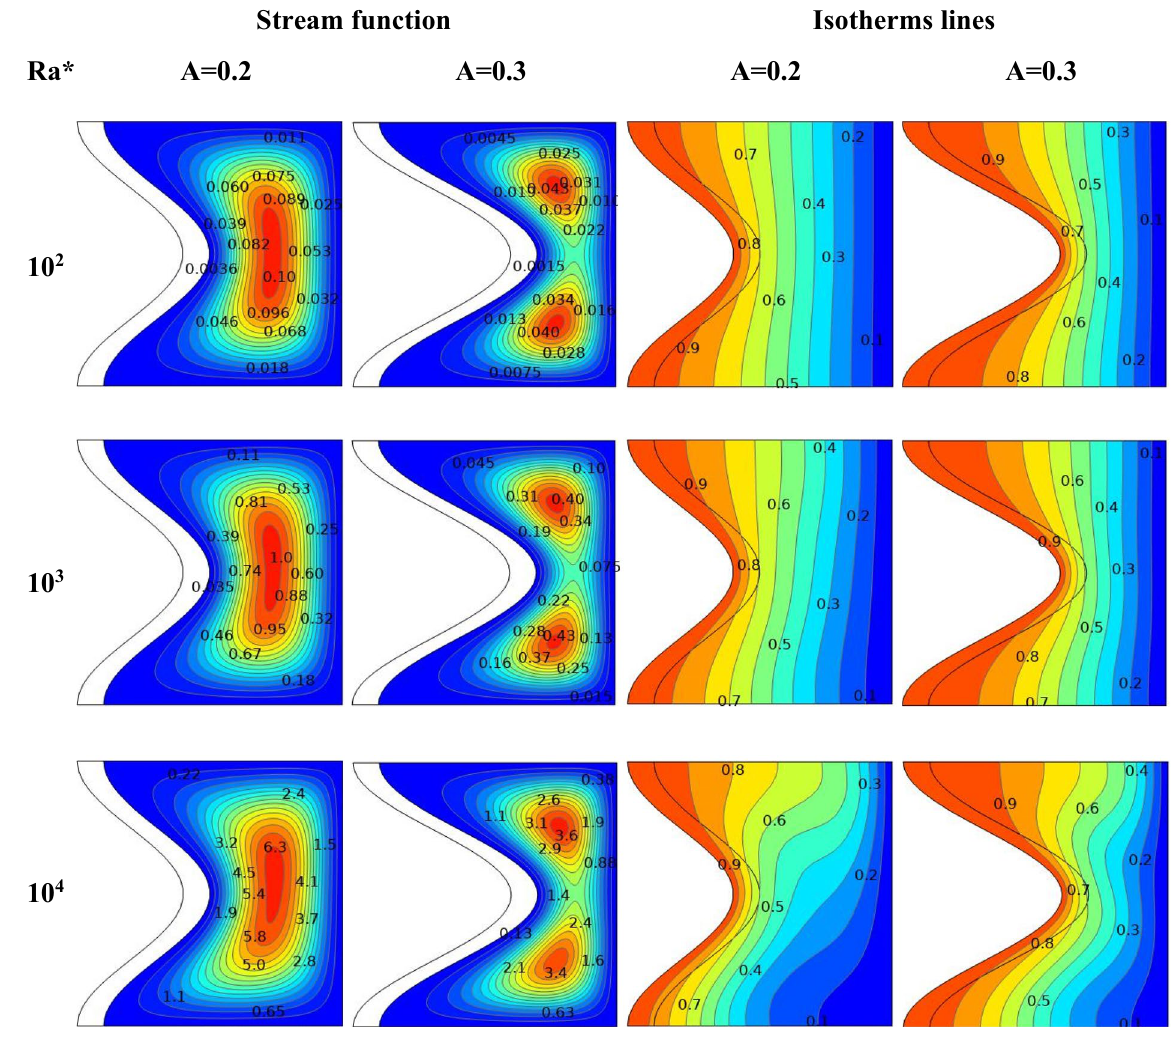
Figure 10. For various values of ′ amplitude of wave A, the streamline, and isotherm contours for various Ra* at ϕ = 0.01 ε = 0.6 Da = 10 –4 kr = 1 D = 0.1 and N =